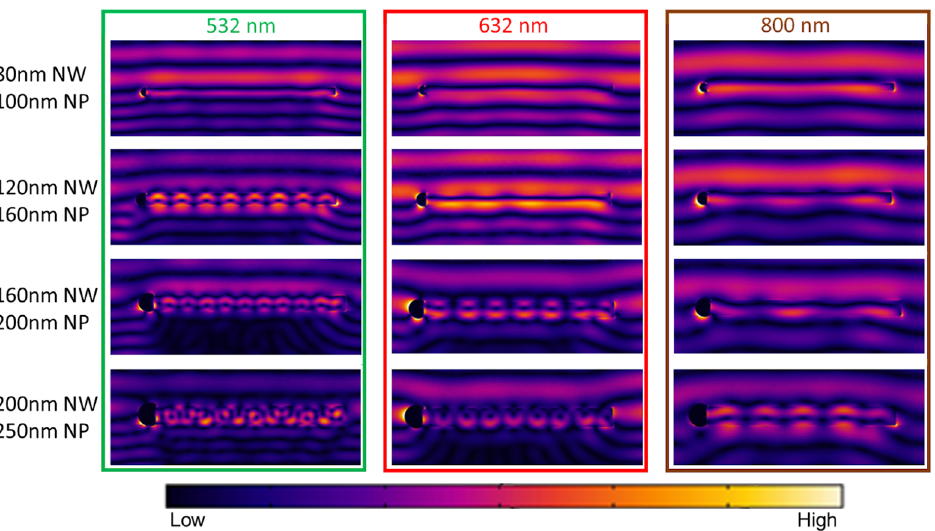
Figure 5. Investigation of the size-dependent resonant optical phenomena in GaP NW with Ga NP (circular segment on the left edge of the wire). The plots demonstrate normalized (E/E 0 ) near field distribution of 532 nm, 632 nm and 800 nm plane waves scattered on the NWs of different diameters.